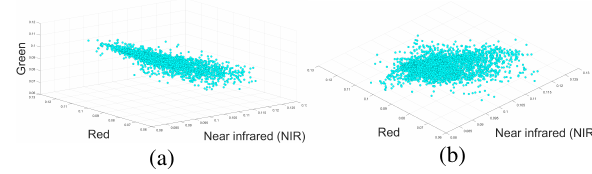
Figure 6. Buildings-streets superpixels in feature space.